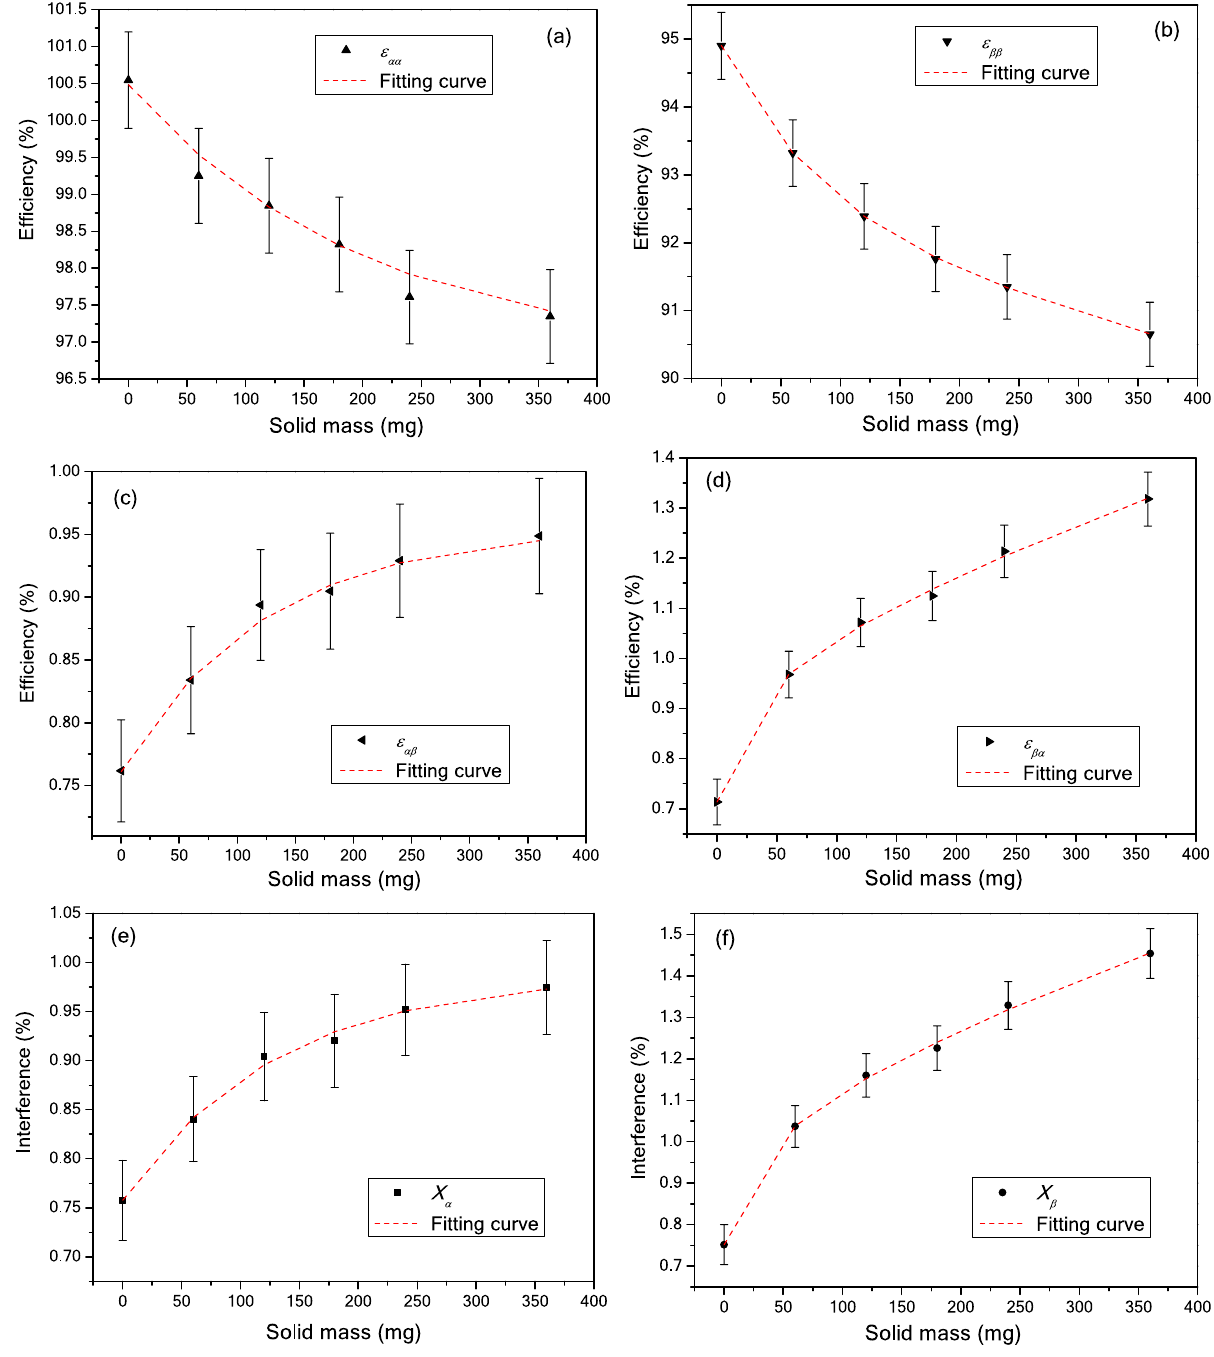
Figure 3. Calibration curves of ε aa ( a ), ε ββ ( b ), ε αβ ( c ), ε βα ( d ), X α ( e ) and X β ( f ) vs. solid mass under the condition of PSA =